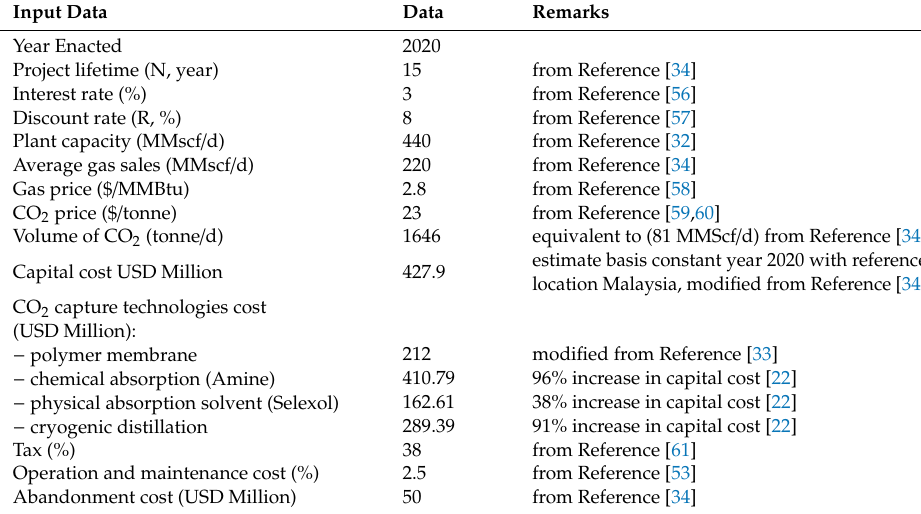
Table 4. Key economic assumptions and references in this